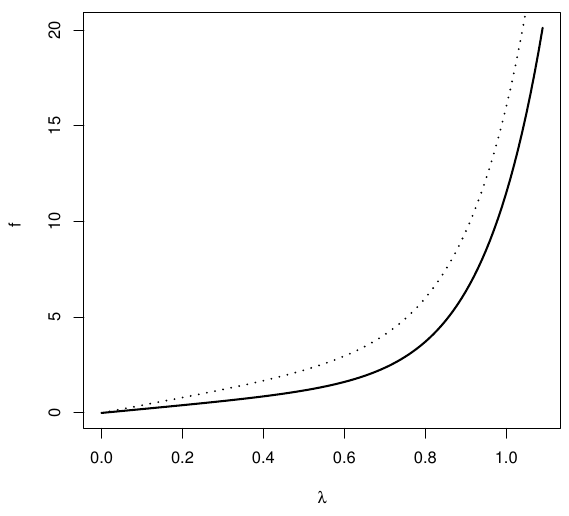
Figure 1. Values of f ( (cid:101) A ) (solid line) and f ( (cid:101) B ) (dotted line) for different values of λ .